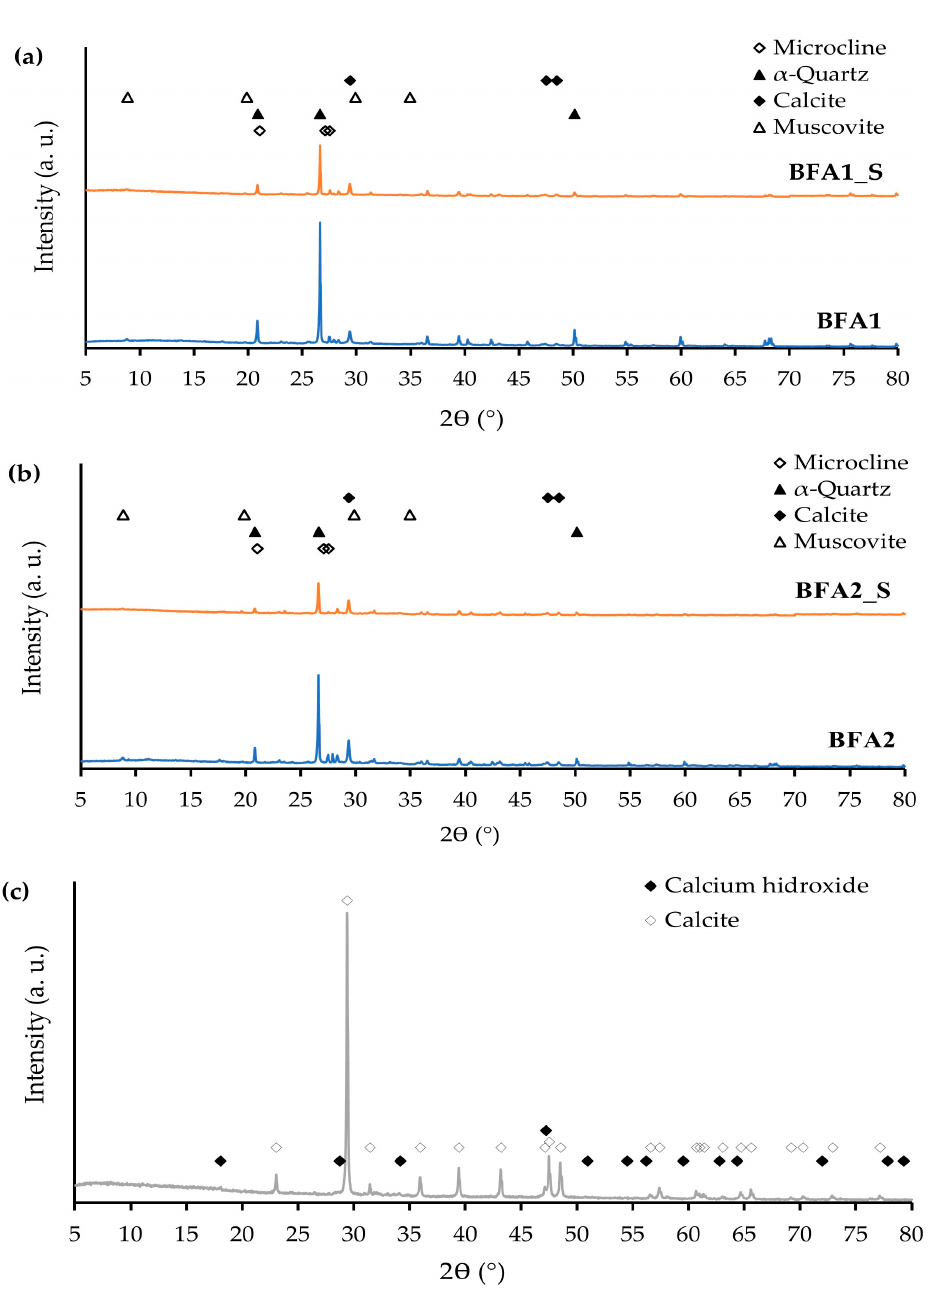
Figure 1. XRD patterns of BFA1 ( a ) and BFA2 ( b ) as received and sieved, and SG ( c ).